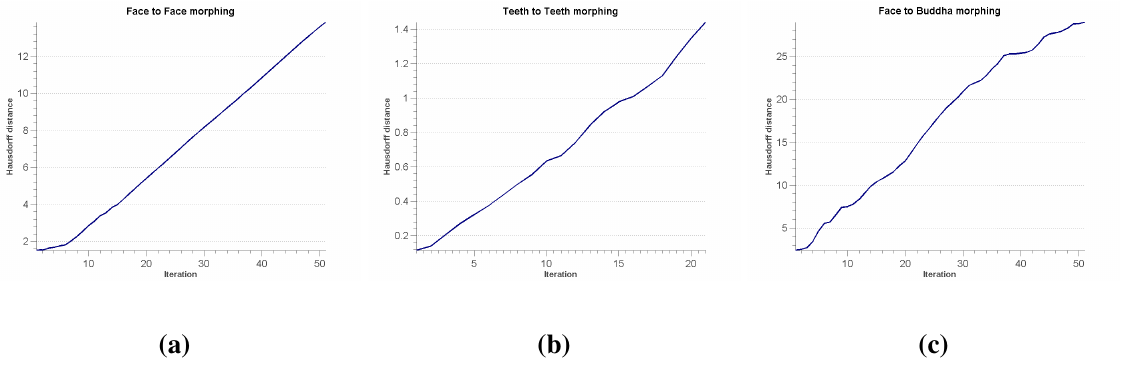
Figure 12. Hausdorff distance between the morphing sequences of each example from their corresponding original surfaces. ( a – c ) The changes of the Hausdorff distance during the morphing examples, as shown in Figures 10–11, respectively.